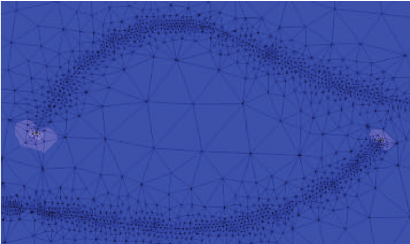
Figure 11: A zoomed-in view for the area around the crack paths in the last step.